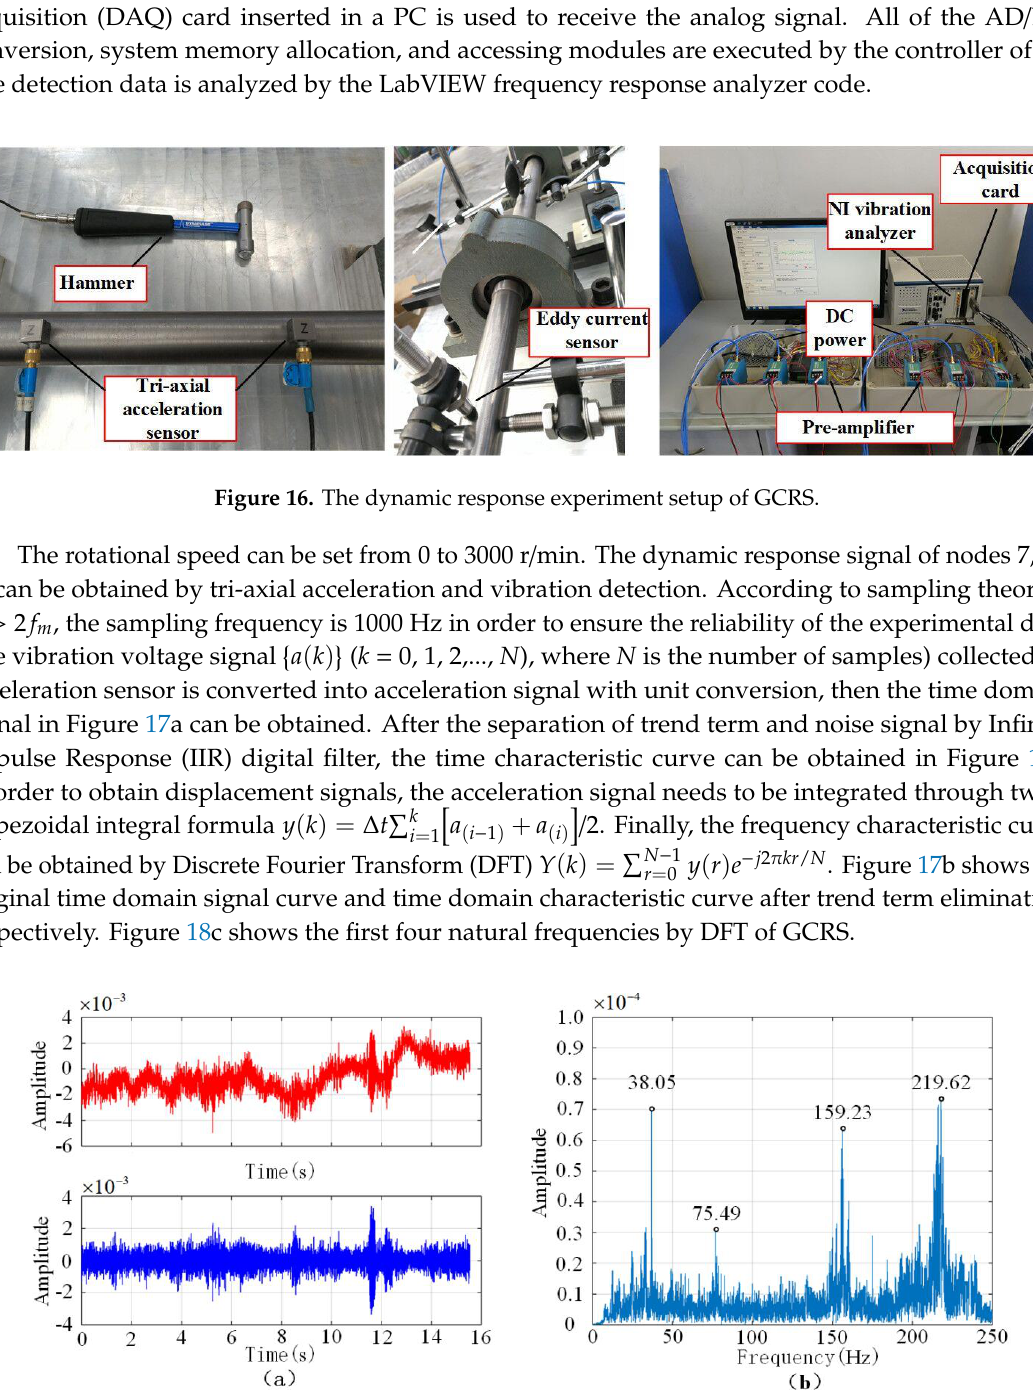
Figure 17. The time–frequency characteristic curve of GCRS. ( a ) The original acceleration signal. ( b ) The frequency characteristic curve.